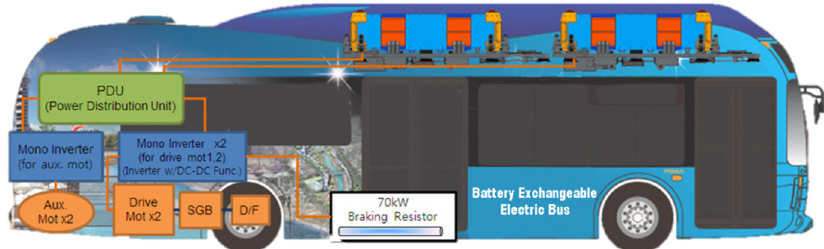
Figure 5. Roof top mount battery exchange